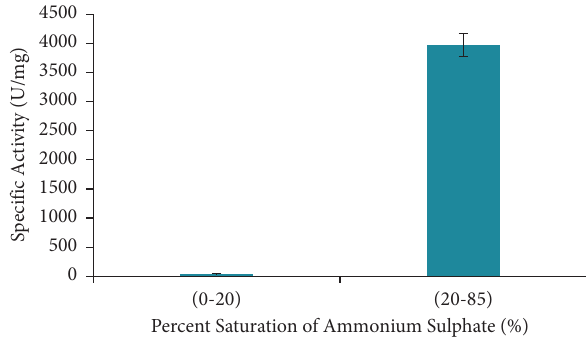
Figure 1: Ammonium sulphate fractionation scheme. The data are presented as mean ± SD; n � 2; a significant difference � p < 0 . 05. The error bars represent standard deviations from two replicates